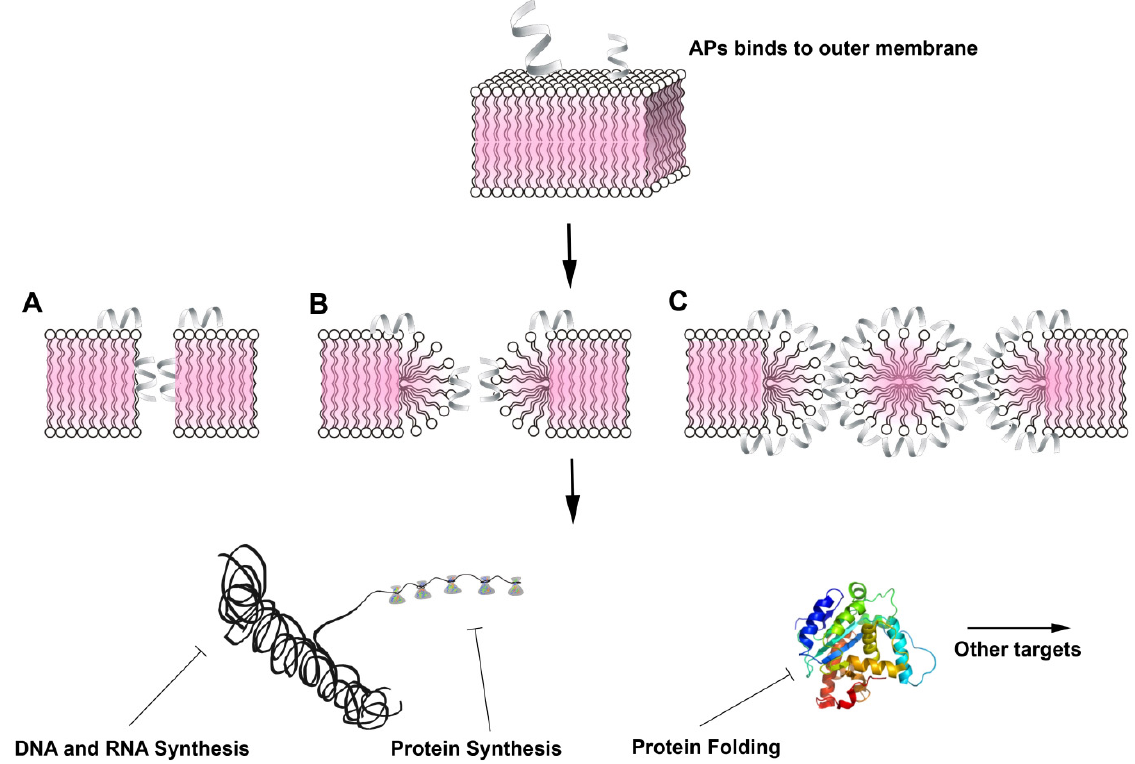
Figure 1. The proposed mechanism of action for APs in bacteria. APs are proposed to associate with the negatively charged surface of the outer membrane. The listed models explaining the mechanisms of membrane permeabilization include: ( A ) barrel-stave: the peptides aggregate and insert into the membrane bilayer in order to align the hydrophobic peptide regions with the lipid core region. The hydrophilic peptide regions form the inner core of the pore. ( B ) Toroidal: the peptides aggregate and induce the lipid monolayers to bend continuously through the pore so that the water core is lined by both the inserted peptides and the lipid head groups. ( C ) Carpet channel: the peptides disrupt the membrane by orienting parallel to the surface of the lipid bilayer and forming an extensive layer or carpet. The net effect of A to C is that some monomers will be translocated into the cytoplasm and can dissociate from the membrane and bind to cellular polyanions such as DNA and RNA, inhibit enzymatic activity such as protein synthesis or chaperone assisted protein folding. Modified from Brodgen et al.